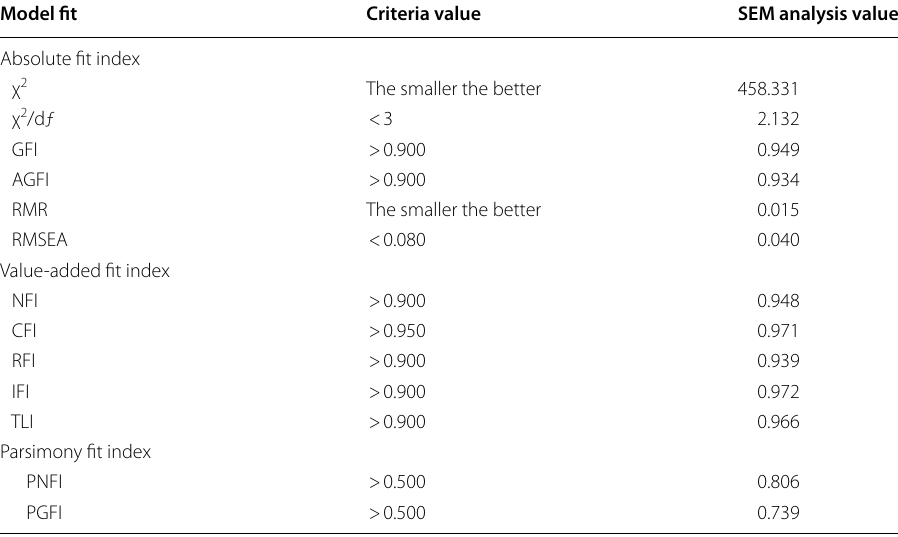
Table 7 Recommended model goodness‑of‑fit indices and indices obtained from SEM Model